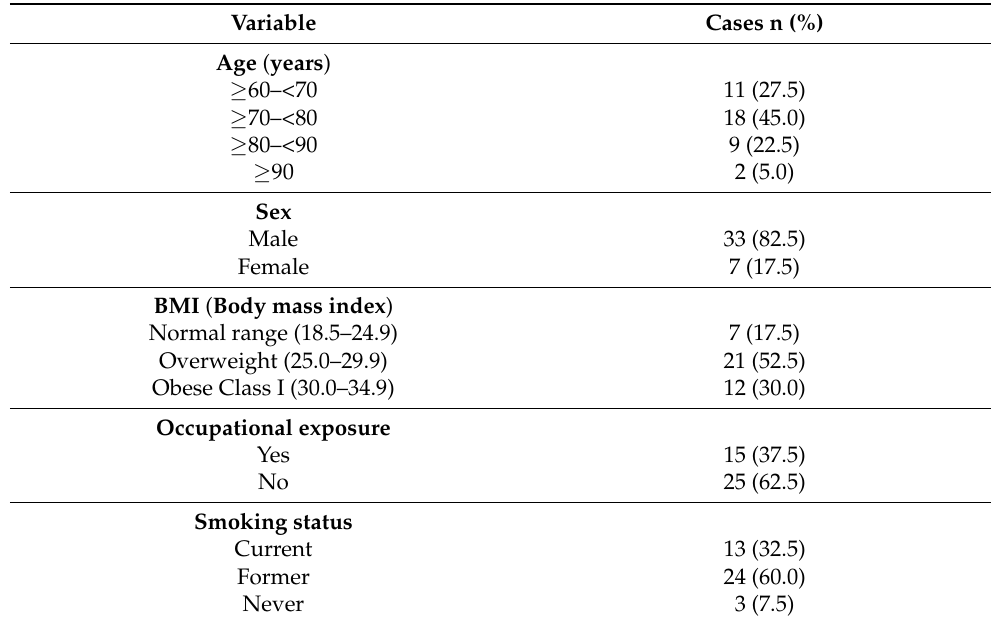
Table 1. Socio-demographic characteristics of study